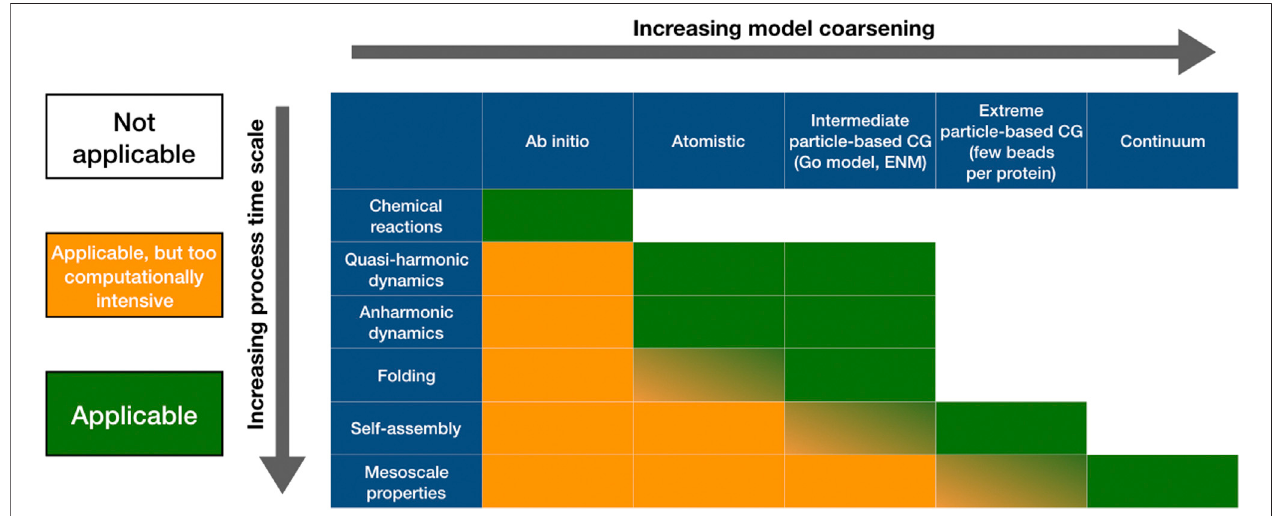
FIGURE 4 | A schematic illustration of the relation between a model ’ s accuracy and its capacity of reproducing long time-scale phenomena. In principle, an extremely accurate model might reproduce all phenomena that take place at a characteristic length and time scale that lies above that of its fundamental constituents; however,practicallimitationsmakeitsusageimpossiblebeyondacertainlimit. Thecoarserthemodel,thelongerthetimescalethatcanbeachieved,attheexpensesof a shorter and shorter list of processes that it can manage to